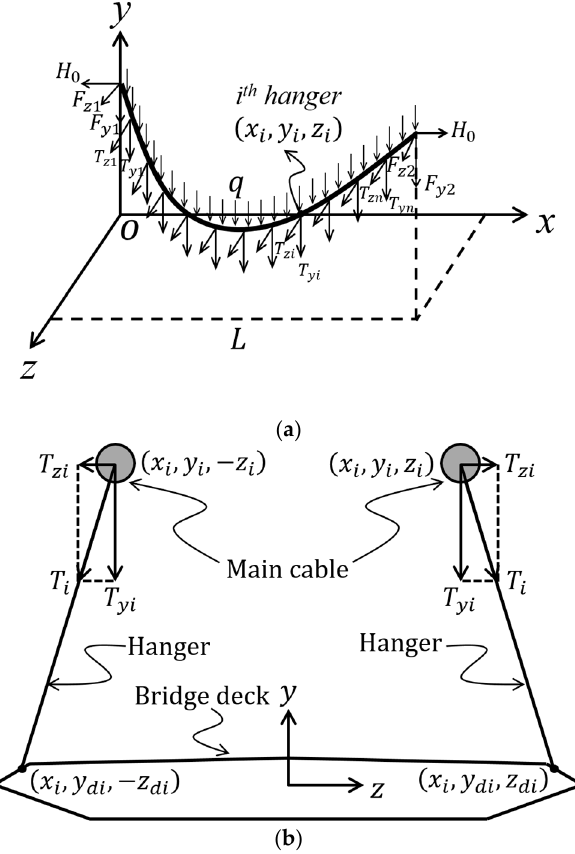
Figure 1. The coordinate system and loading distribution of the spatial main cable: ( a ) Three-dimensional coordinate; ( b ) Two-dimensional coordinate of the cross section.